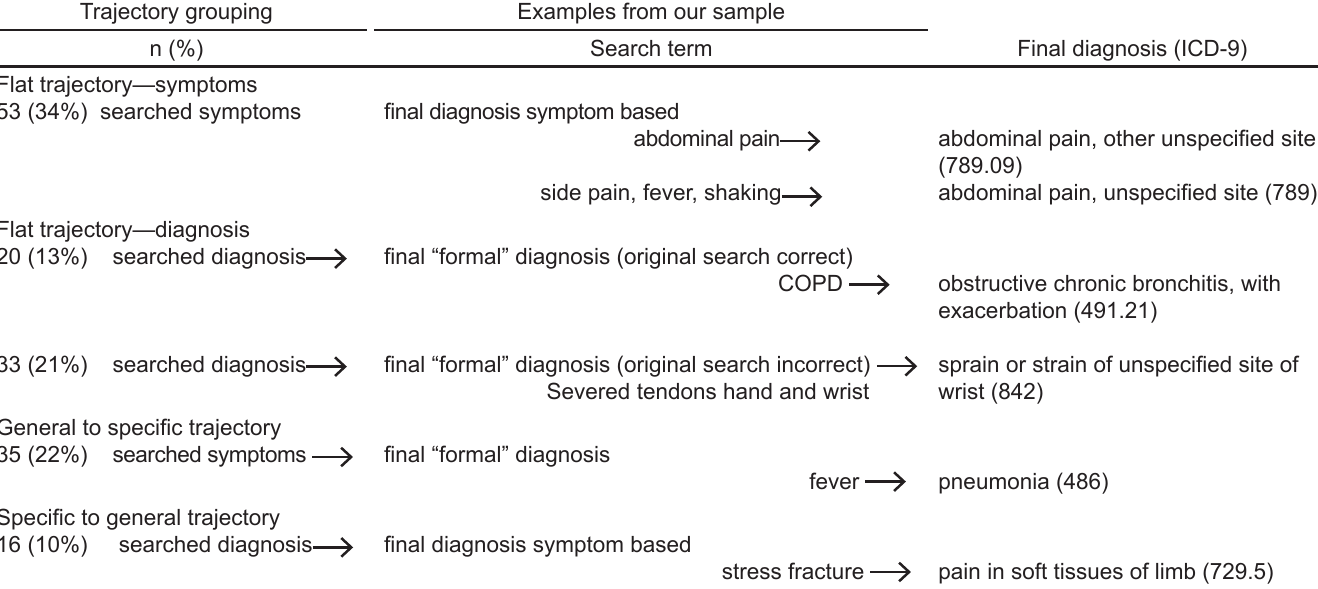
Table 3. The trajectory between initial Internet search term and final emergency department